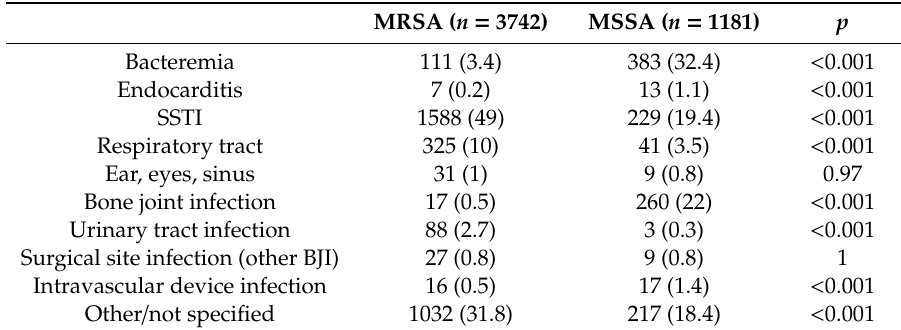
Table 2. Clinical diagnosis of patients with MSSA and MRSA CC398 infections (only articles with clinical infection details were